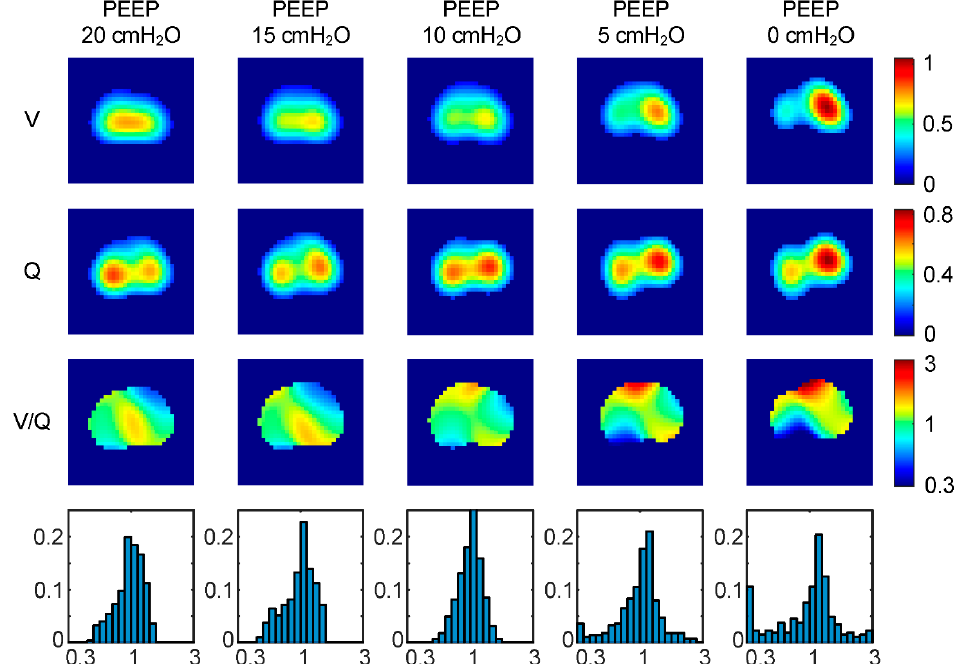
Figure 6. Regional lung ventilation (V) and perfusion (Q) obtained by EIT using a contrast agent in a decremental PEEP trial. Homogeneity of the distribution of regional ventilation to perfusion ratio (V / Q) slightly increases from 20 to 10 cm H 2 O, whereas a strong homogeneity decrease is observed from 10 to 0 cm H 2 O.